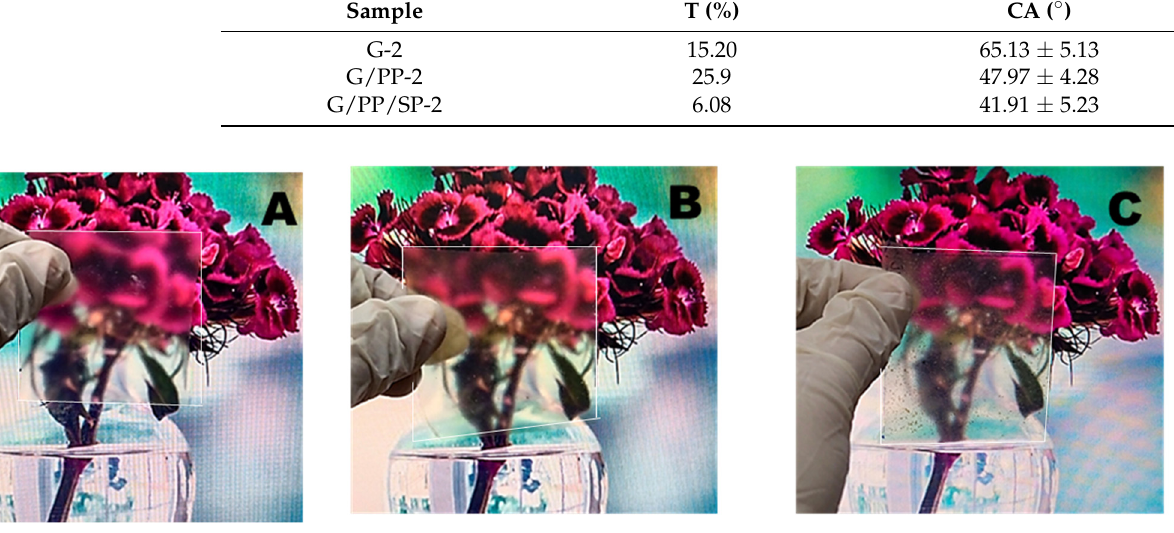
Figure 4. Transparency of edible film (white line indicates the film area): ( A ) gelatin film, ( B ) papaya gelatin film, ( C ) soy protein papaya gelatin film.